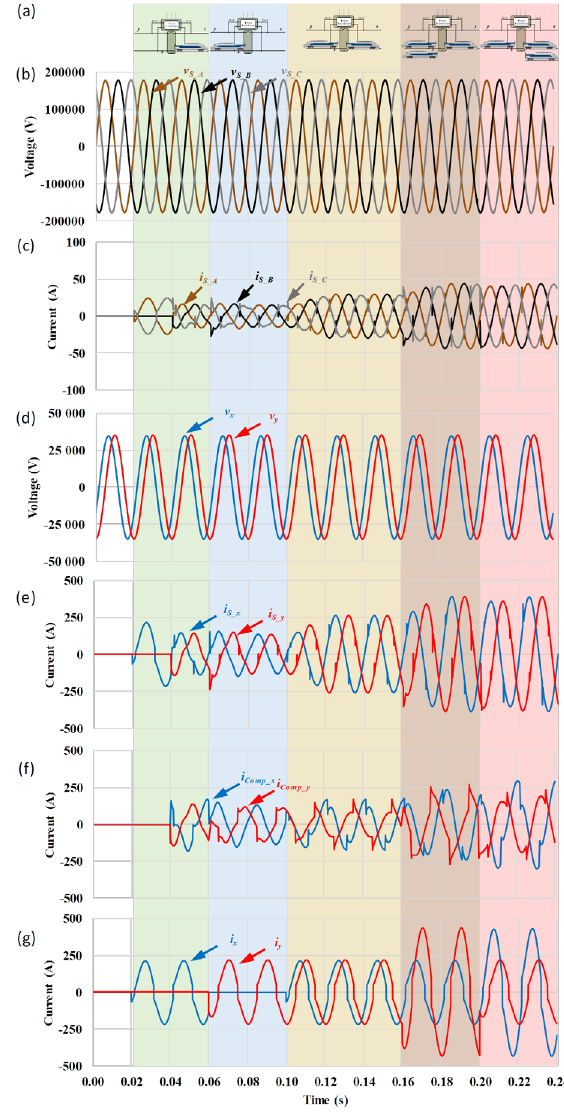
Figure 10. Simulation results of the RPC compensating the power quality problems existing in the railway system powered by a V/V power transformer: (a) Case scenarios with different number of locomotives in the catenaries; (b) Three- phase power grid voltages v S_A , v S _ B and v S_C ; (c) Currents of the power grid i S_A , i S _ B , i S_C ; (d) Voltage in the catenaries, v x and v y ; (e) Currents in the low-voltage side of the V/V power transformer, i x and i y ; (e) Compensation currents, i Comp_x